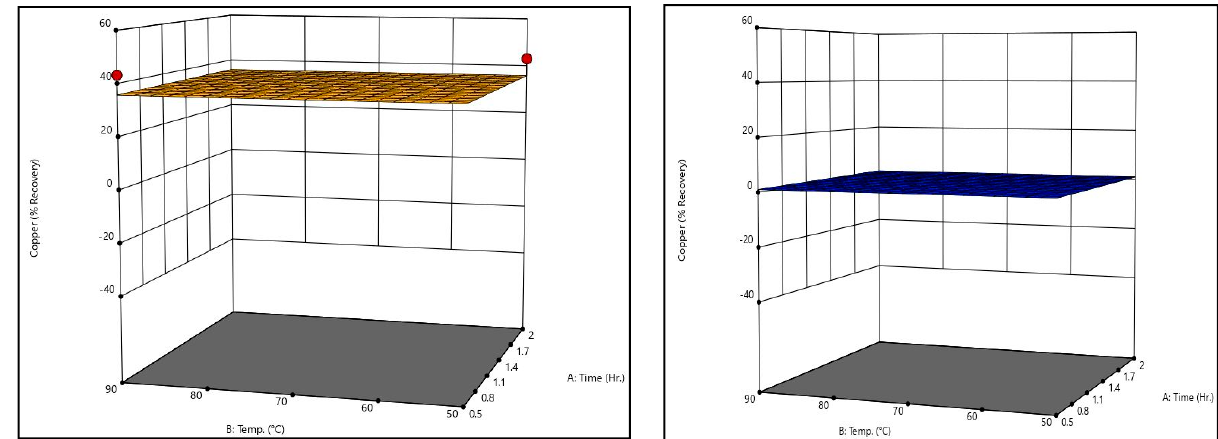
Figure 7. Caustic leaching copper recovery response surfaces: low alkalinity ( left ) and high alkalinity ( right ). Figure 8 shows bismuth recovery response surfaces from the caustic leaching design matrix at the minimum and maximum temperatures tested. It can be seen that the surfaces are identical, meaning temperature has little to no effect on bismuth recovery. Additionally, it is evident that time has no meaningful effect on bismuth recovery. Only sodium hydroxide concentration has a measurable effect on bismuth recovery; higher sodium hydroxide concentrations are associated with higher bismuth recoveries. That said, it should be noted that increasing sodium hydroxide did not increase bismuth recovery by a meaningful degree within the ranges tested.